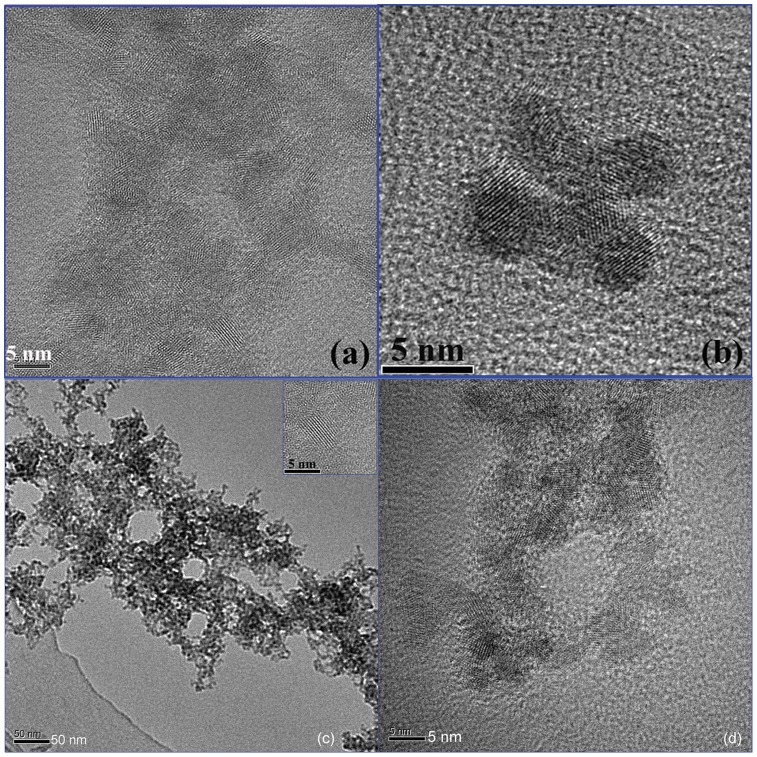
TEM and HRTEM images of as-prepared CdSe0.2S0.8 nanocrystals.